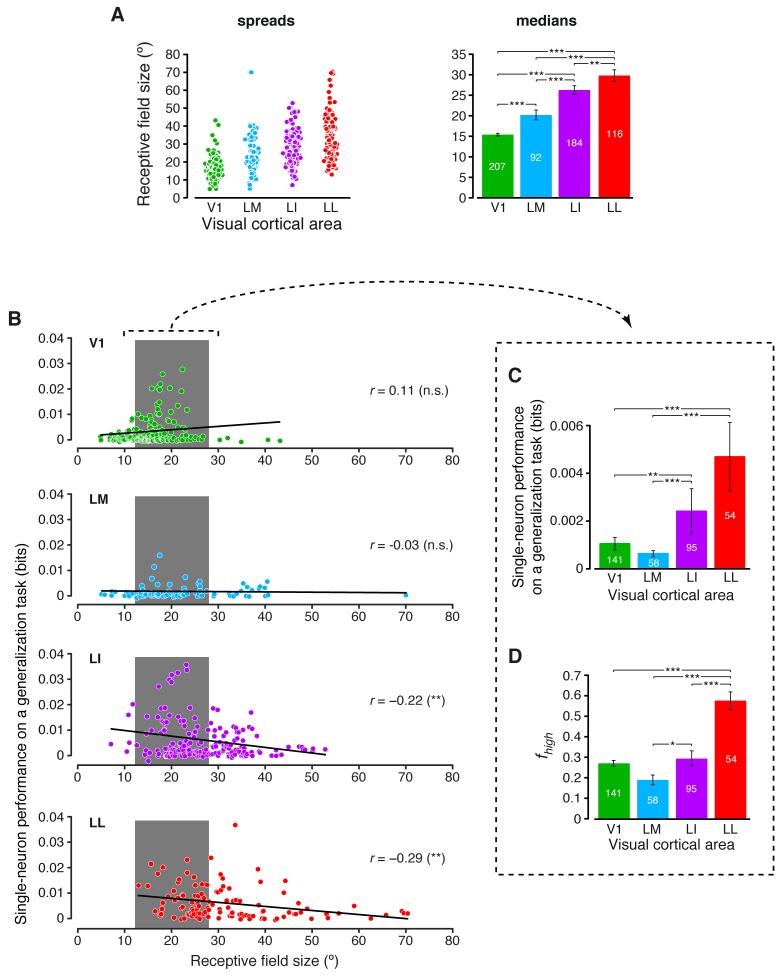
Single-neuron decoding and mutual information metrics, compared across neuronal subpopulations with matched RF size.(A) Spreads (left) and medians ± SE (right) of the RF sizes measured in each visual area (*p<0.05, **p<0.01, ***p<0.001; 1-tailed U-test, Holm-Bonferroni corrected). The number of cells in each area for which RF size could be estimated is reported on the corresponding bar of the right chart. Spreads and medians of the response latencies are reported in Figure 7—figure supplement 1. (B) For each visual area, the generalization performances achieved by single neurons (same data of Figure 6B) are plotted against the RF sizes (same data of panel A). In the case of LI and LL, these two metrics were significantly anti-correlated (**p<0.01; 2-tailed t-test). (C) Median generalization performances (± SE) achieved by single neurons, as in Figure 6B, but considering only neuronal subpopulations with matched RF size ranges, indicated by the gray patches in (B) (*p<0.05, **p<0.01, ***p<0.001; 1-tailed U-test, Holm-Bonferroni corrected). The number of neurons in each area fulfilling this constraint is reported on the corresponding bar. (D) Median fraction of luminance-independent stimulus information (± SE) conveyed by neuronal firing as in Figure 3C, but including only the RF-matched subpopulations used in (C). Significance levels/test as in (C).